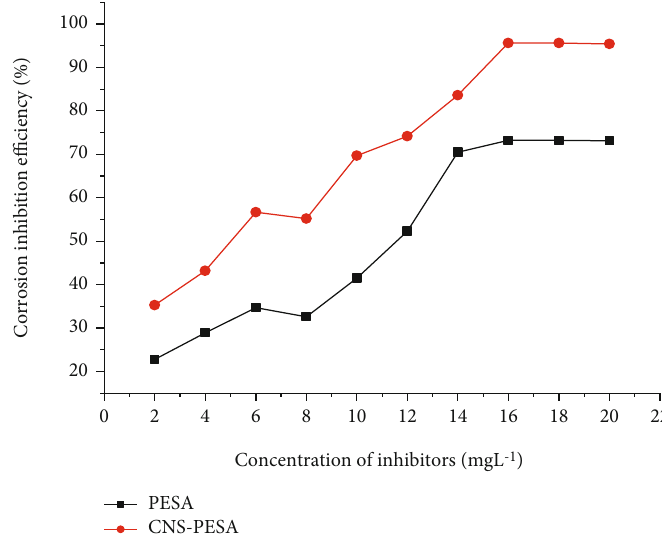
Figure 7: Corrosion inhibition performance of PESA and